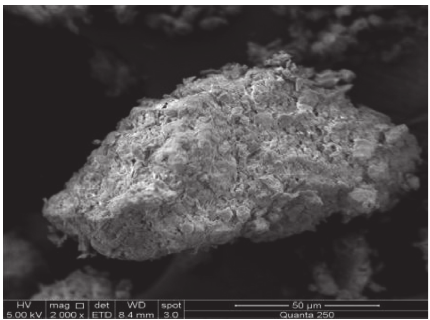
Figure 1: SEM image of the nonmodified sepiolite.